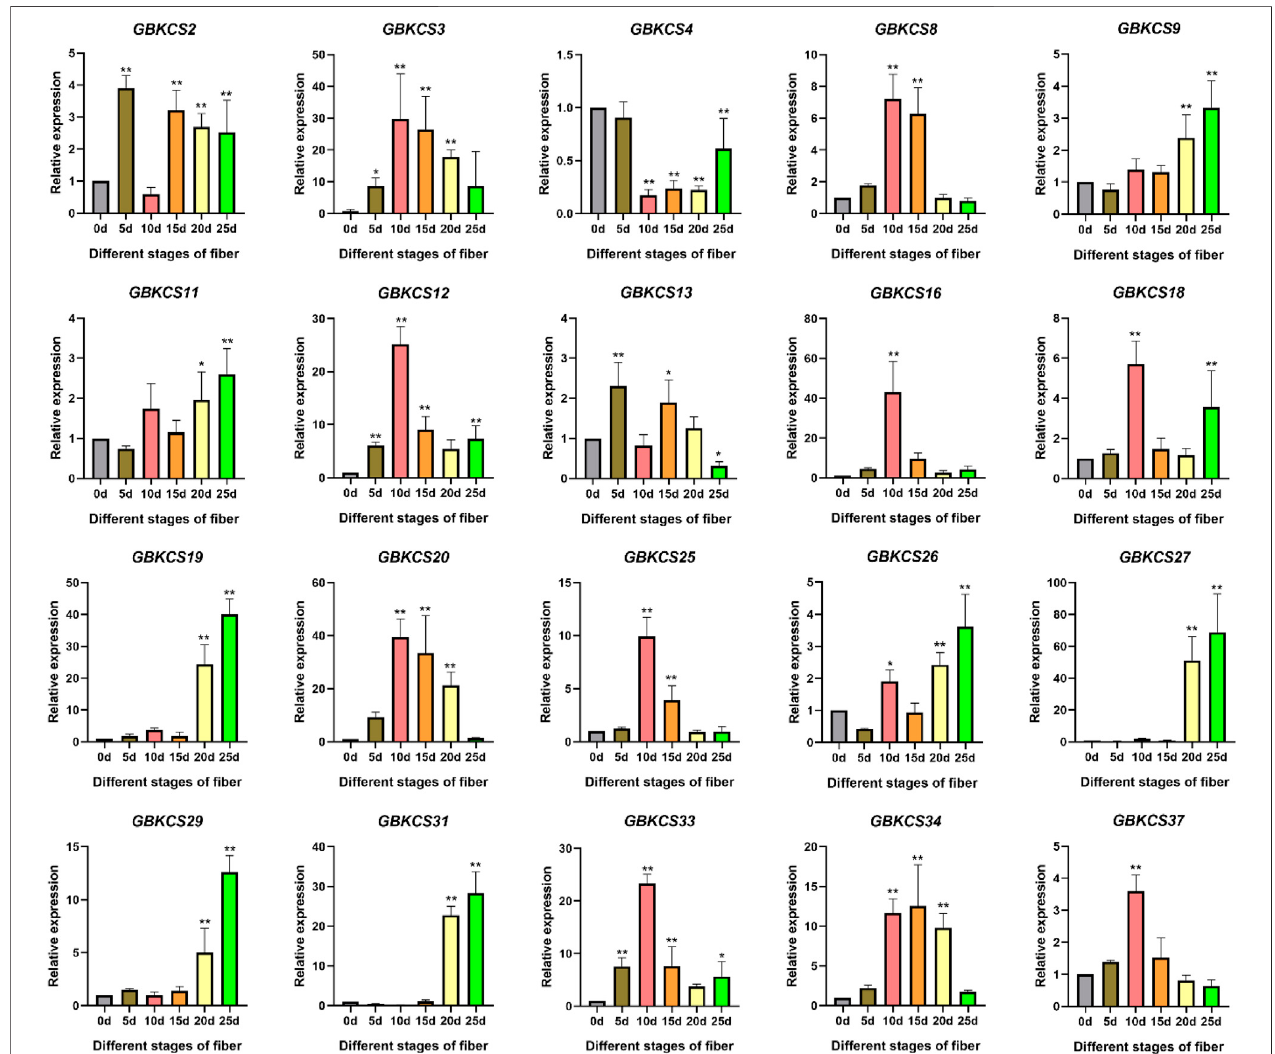
Frontiers in Genetics |